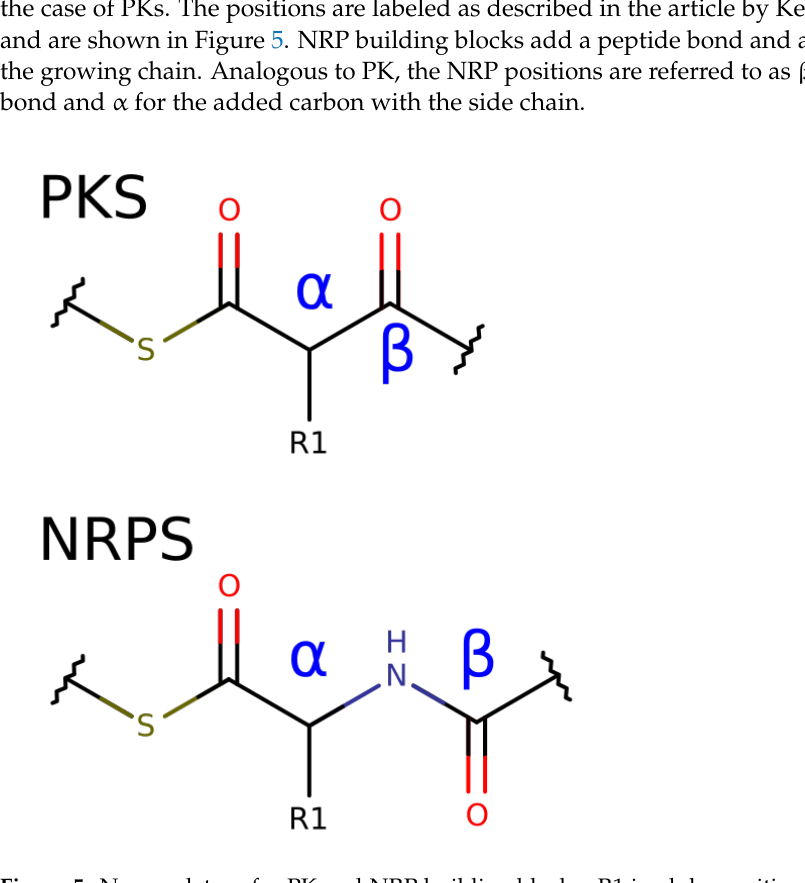
Figure 5. Nomenclature for PK and NRP building blocks. R1 in alpha position is defined by the substrate choice of the AT- or A-domain. The α -position of PK substrates can be further modified co-synthetically by C-methyltransferases. The stereo configuration of the α -carbon of NRP substrates is defined by the presence of an E domain. The β -position of PK substrates can be further reduced. For NRP substrates, only the nitrogen atom, also referred to as β -position, can be methylated. The PKS reduction pattern and putative methylation are created as described in Figure